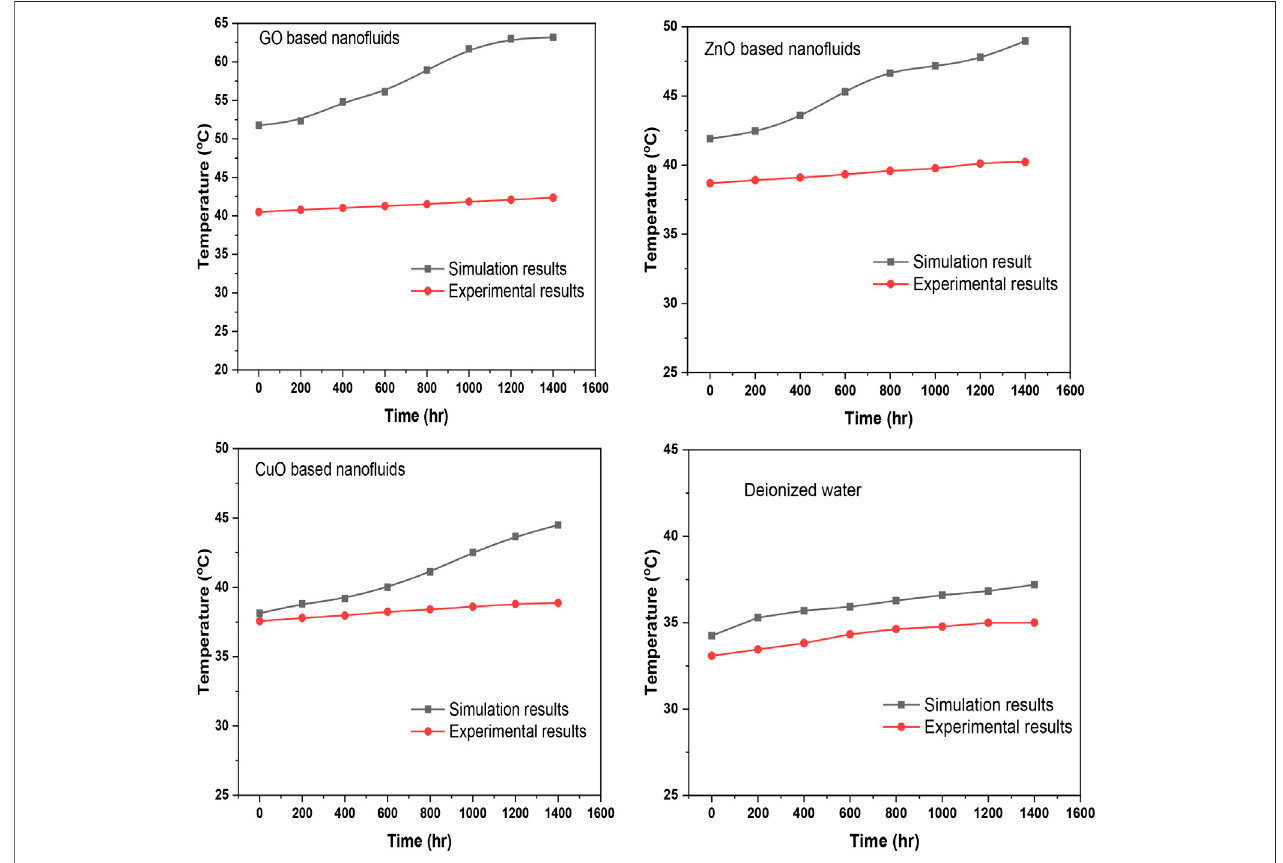
FIGURE 6 | Variation in experimental and simulation results for the outlet temperature of the solar collector for various working fl uids.